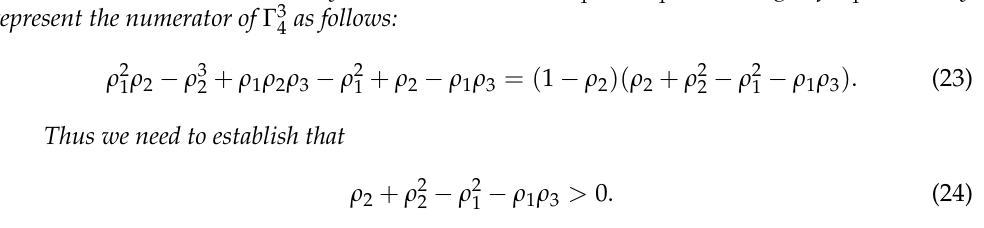
, Γ 3 , and Γ 4 as the functions of H . 4 4 4